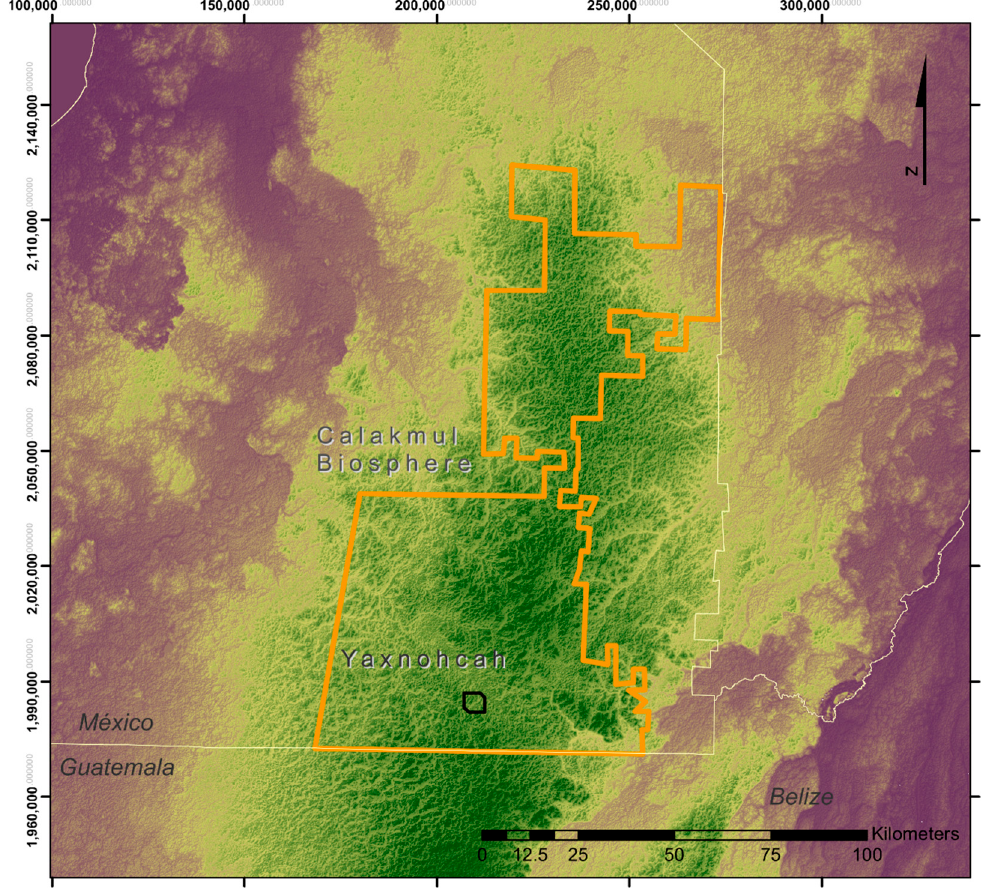
Figure 1. Location of the study area in relation to the Calakmul Biosphere Reserve, SRTM elevation, UTM Zone 16N WGS 84.